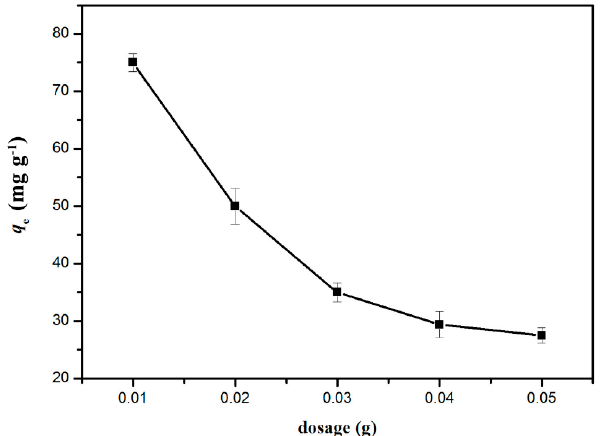
Figure 8. Effects of adsorbent dose on Cu 2+ adsorption by the GO(20)/cellulose(100) hydrogel. The error bars represent standard deviations based on three measurements.